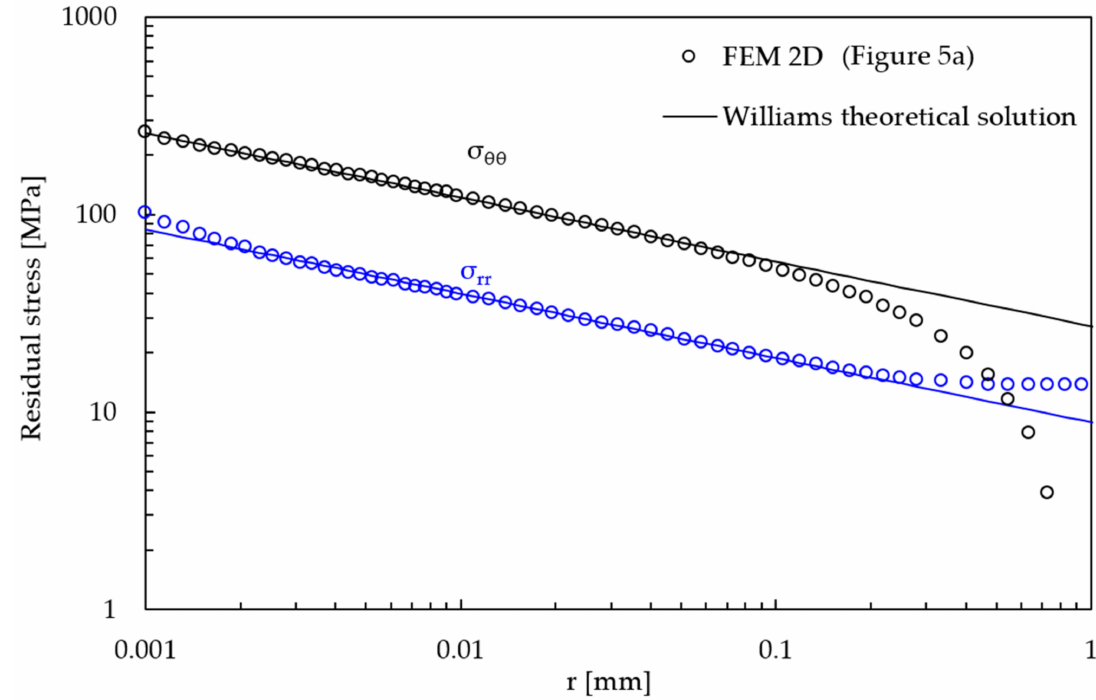
Figure 7. Asymptotic residual stress field obtained from the 2D FE model with extremely refined mesh (Figure